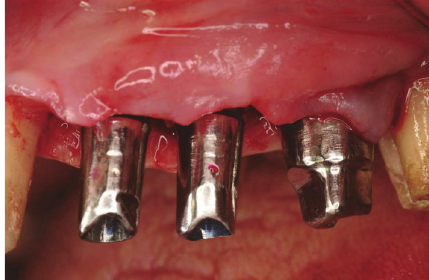
Figure 28: Tightening of the provisional abutments.